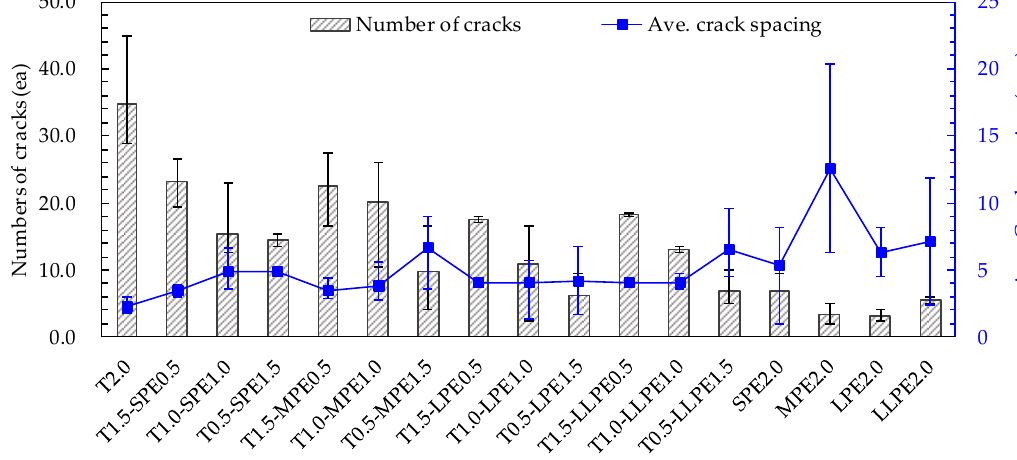
Figure 8. Number of cracks and average crack spacing.